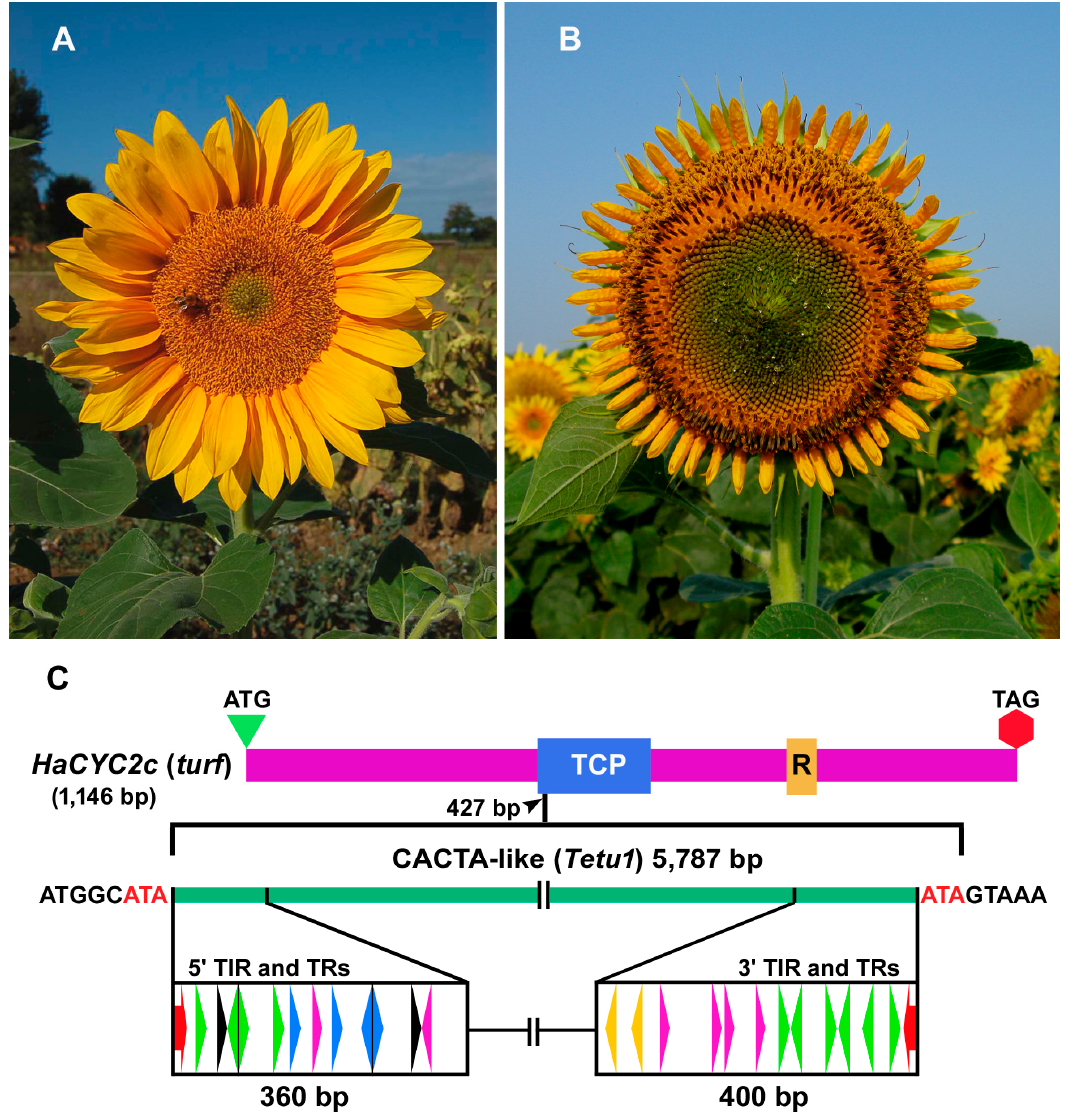
Figure 1. The phenotypic effect of the insertion of the CACTA-like transposable element (TE) in the TEOSINTE BRANCHED1/CYCLOIDEA/PROLIFERATING NUCLEAR ANTIGEN CELL FACTOR (TCP) 1 and 2 motif of a CYCLOIDEA gene ( HaCYC2c ) controlling flower symmetry in sunflower [20]. ( A ) Inflorescence of normal sunflower with zygomorphic ray flowers. ( B ) Inflorescence of the tubular ray flower ( turf ) mutant. ( C ) Schematic representation of the coding region (CDS) of the HaCYC2c gene in the turf mutant. The HaCYC2c conserved domains, TCP and R, are boxed in blue and brown, respectively. The CACTA-like transposable element of turf1 ( Tetu1 ) is inserted into the basic motif of the TCP domain (427 bp after the start codon). The insertion originates a perfect three bp (ATA, in red) target site duplication (TSD). The structure of both 5 ′ (360 bp) and 3 ′ (400 bp) regions, recognized by terminal inverted repeats (TIRs) and sub-terminal repeats (TRs) of Tetu1 , are depicted. The red arrows indicate the TIRs; the colored triangles indicate the TR regions of 9–11 bp units that are repeated in direct and inverted orientations. Each triangle color distinguishes an identical sequence in direct or inverted orientations. The TR sequences were identified by dot-plot analyses [19,20].